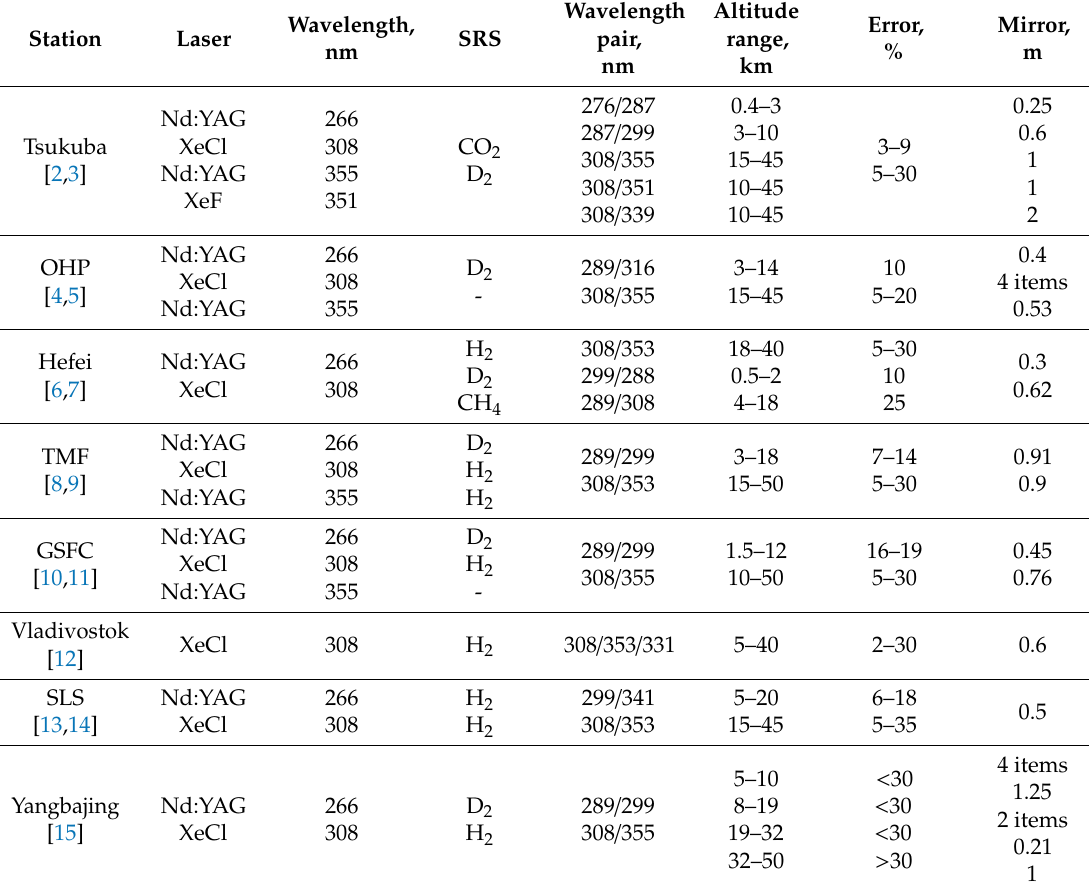
Table 1. Lidar complexes for measuring the vertical distribution of